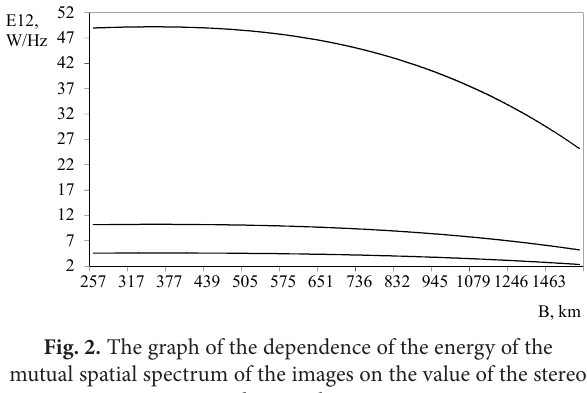
Fig. 1. Graph of the error in determining the heights of objects on the value of the stereo shooting basis The graphs of the dependences of the error in determin- ing the heights of objects on the value of the stereo recog- nition basis are presented in Fig. 1 . Analysis of the graphs shows that with an increase in the basis value, the error in measuring the heights of objects first improves and then worsens. This deterioration is caused by the fact that stereo pair images are obtained from different spatial points and at the same time perspective distortions and distortions in relief appear on the images [4]. Accordingly, with an increase in the basis of shooting, these distortions will increase. Due to this, the energy of the mutual spatial spectrum of images (4) decreases ( Fig. 2 ). A decrease in the energy of the mutual spatial spectrum of the images leads to a deterioration in the parallax determination error when the stereo images are automatically combined by the extreme correlation method ( Fig. 3 ).